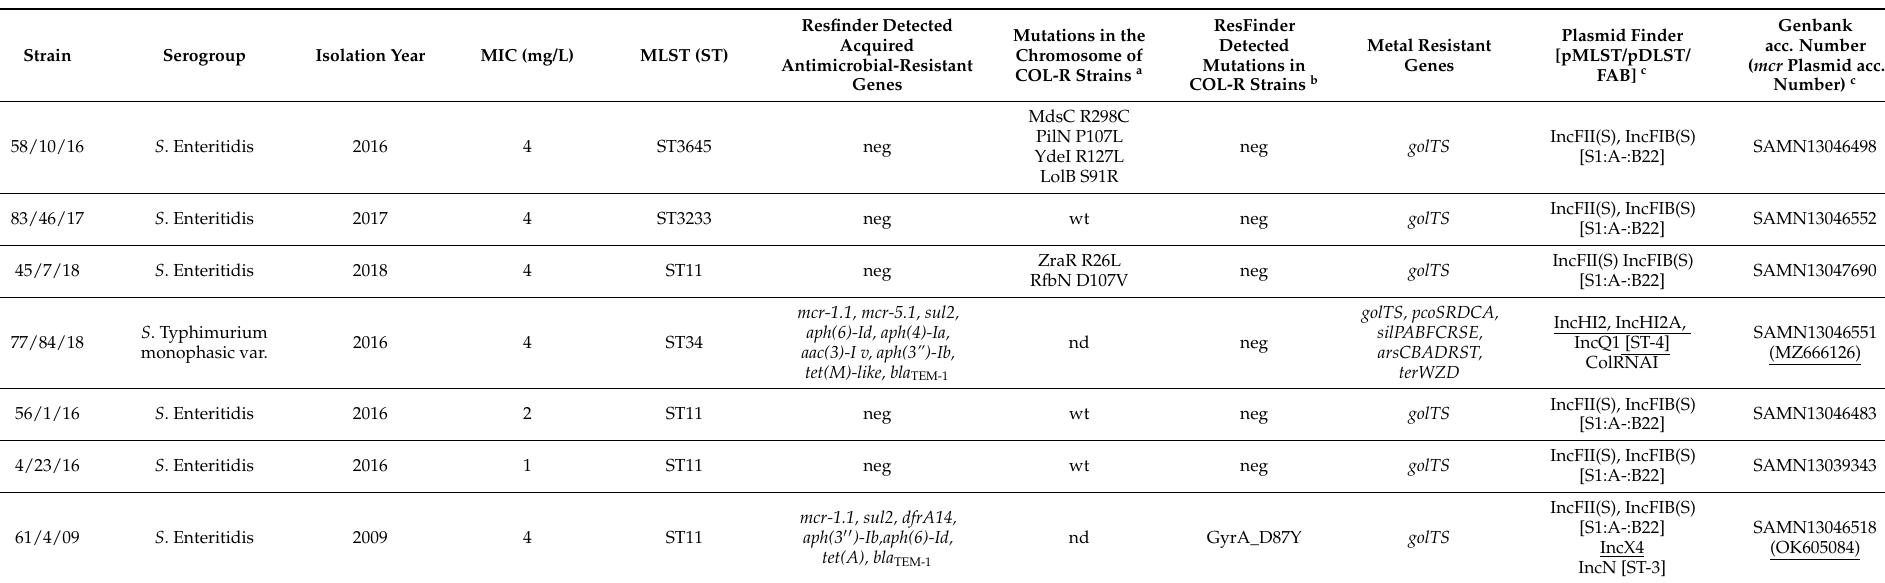
Table 1. Genetic and phenotypic characteristics of the four COL-R S. enterica isolates analysed in this study compared with COL-S strains isolated in the same 2016–2018 period and with the COL-R mcr-1 positive strain isolated in